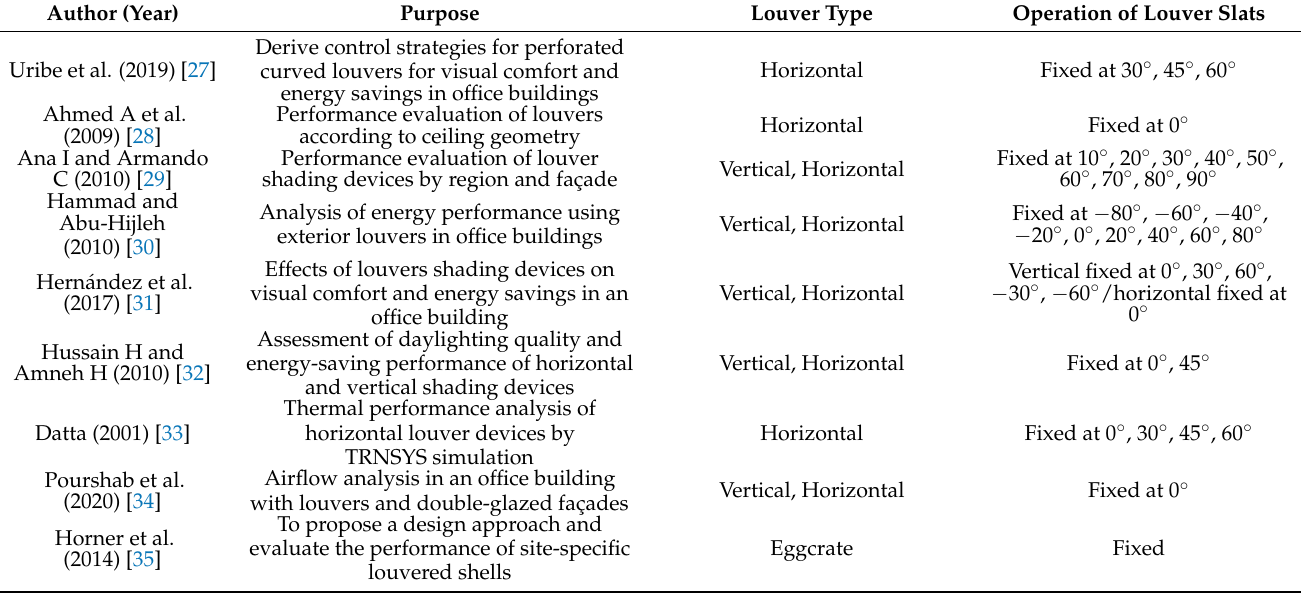
Table 1. Consideration of previous work on louver shading systems.